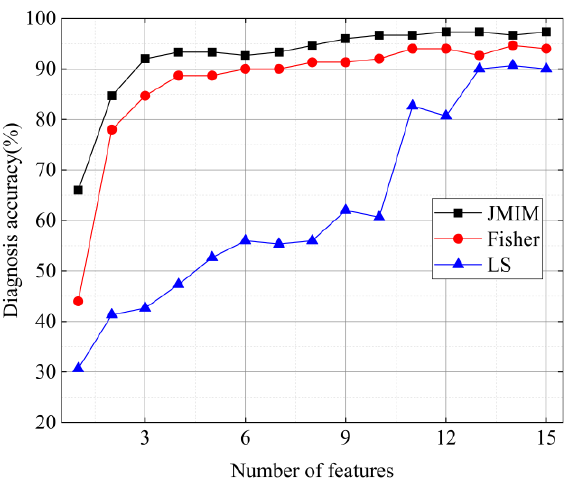
Figure 14. The diagnosis accuracy of JMIM, Fisher and LS feature selection methods.